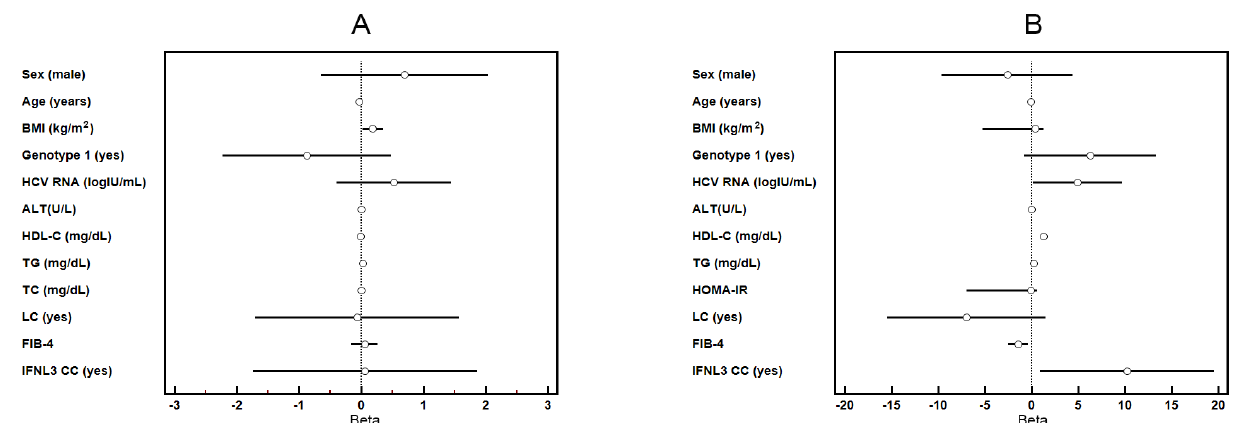
Figure 2. Forrest plot of the Beta and 95% confidence intervals of Beta for HOMA-IR ( A ) and TC ( B ). BMI: body mass